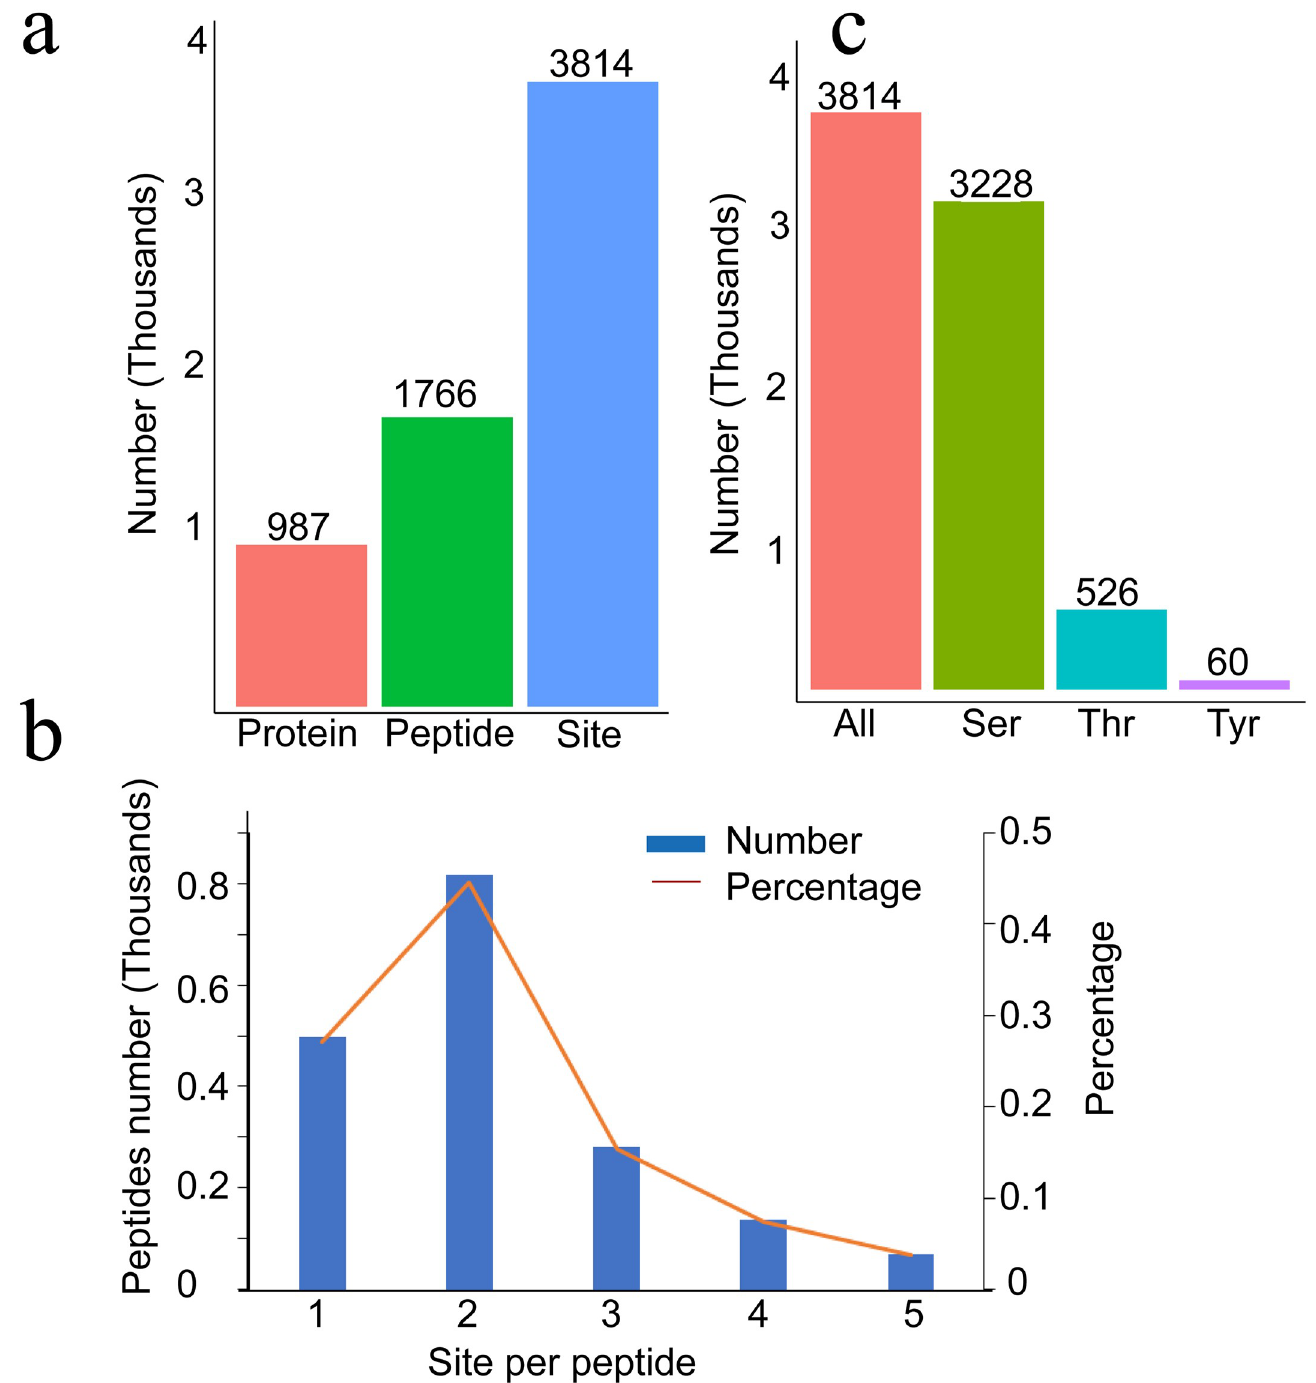
Fig 1. Phosphorylation statistics. (a) Identified phosphoproteins, (b) phosphopeptide site analysis, and (c) patterns of identified phosphorylation sites. https://doi.org/10.1371/journal.pone.0244198.g001 associated with cellular process, metabolic process, biological regulation process, localization and response to stimulus. MF classes were involved in catalytic and transporter activity, and CC classes were mostly involved in membrane, cell, cell part, membrane part, and organelle (Fig 2b).